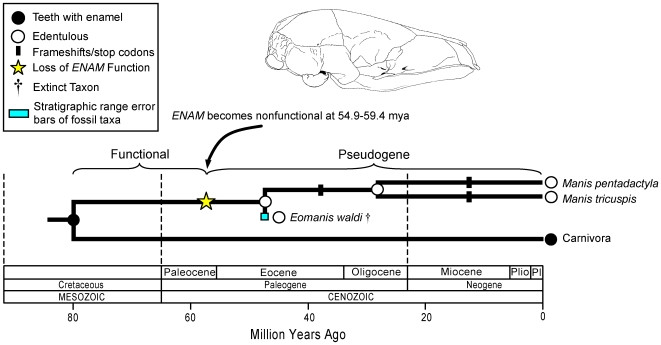
A synthetic interpretation of the history of enamel degeneration in Pholidota (pangolins) based on fossils, phylogenetics, molecular clocks, frameshift mutations, and dN/dS ratios.Estimates for the timing of the transition from functional gene to pseudogene are based on decomposition of mixed dN/dS history into two distinct episodes of evolution under purifying selection and neutral evolution, respectively. The divergence time between Pholidota and Carnivora (79.8 mya) is from Murphy and Eizirik [23]. The divergence time between Manis pentadactyla and M. tricuspis (27.9 mya) is based on molecular dating analyses with ENAM (see Methods). The age of the oldest pangolin, Eomanis from the Eocene Messel deposits of Germany, is ∼47 mya [29].